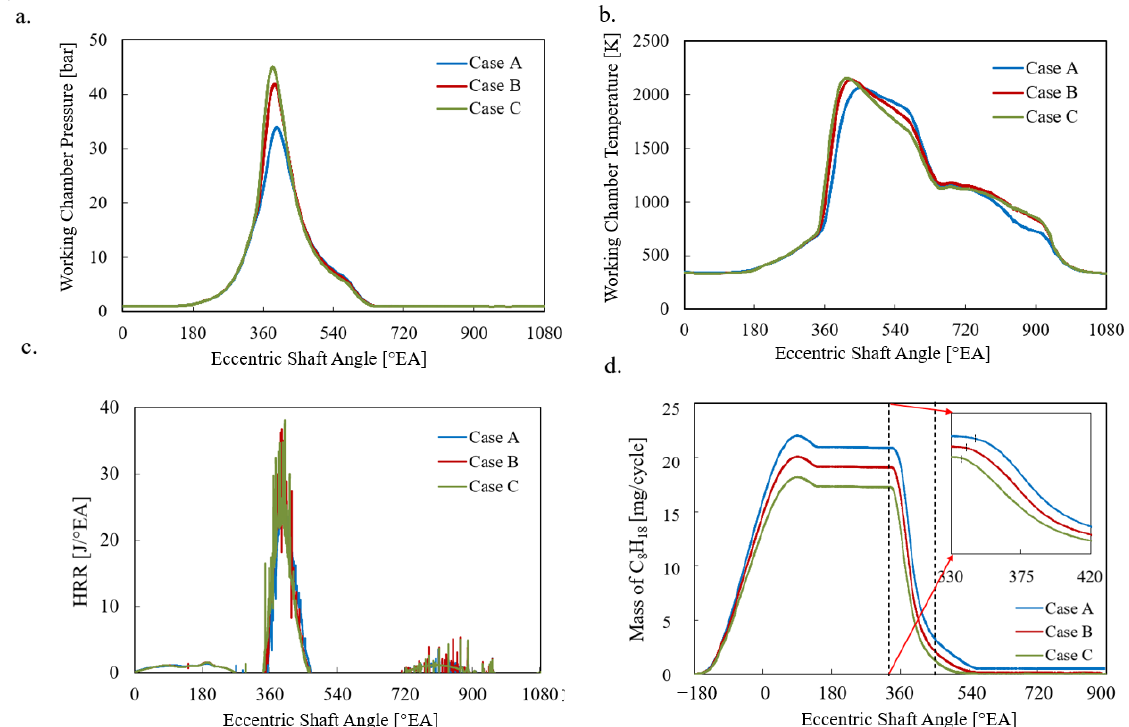
Figure 11. Comparison of ( a ) pressure, ( b ) temperature, ( c ) HRR and ( d ) mass of C 8 H 18 for different cases.